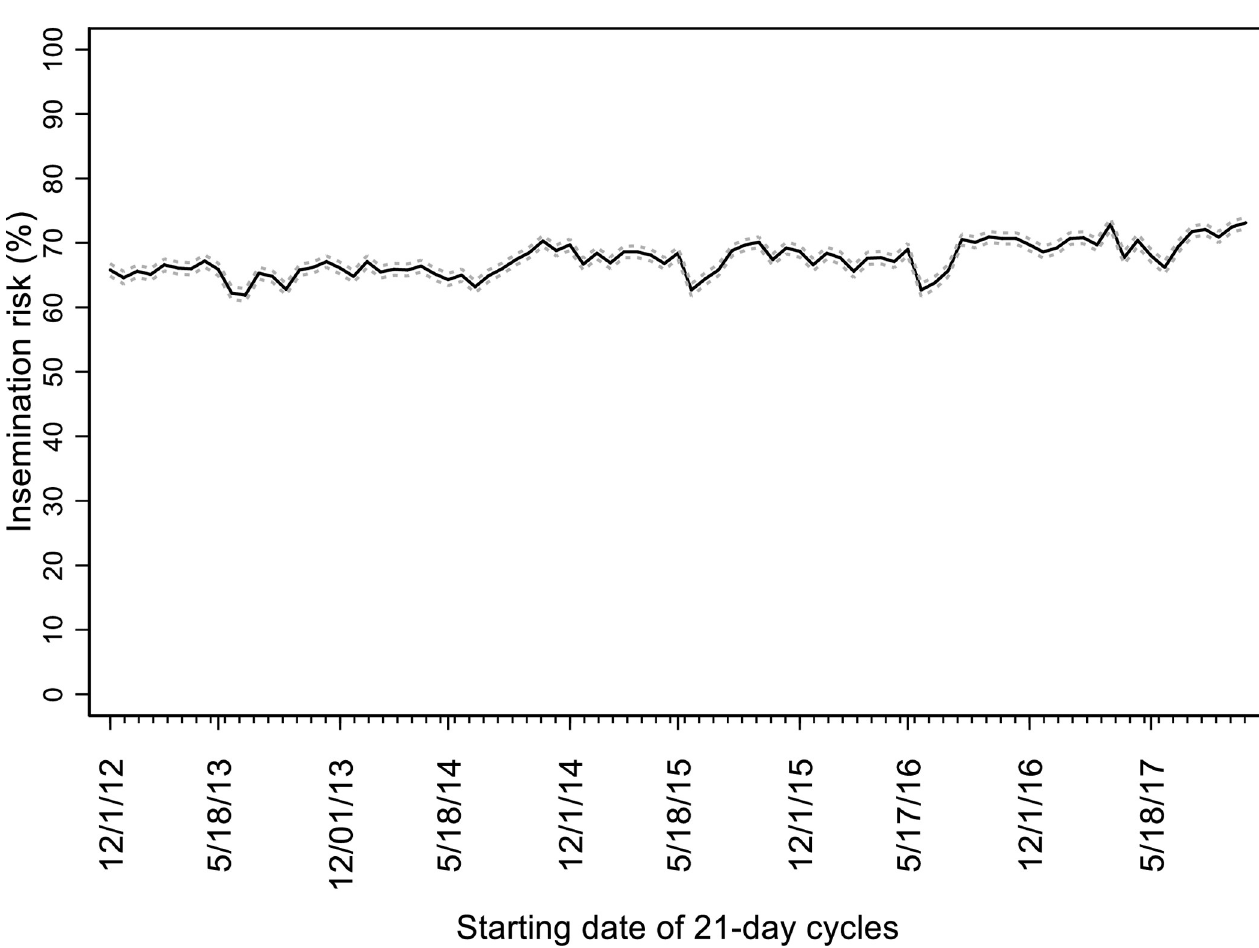
Fig 1. Insemination risk of 9 large dairy herds located in Kansas. Black solid line represents mean insemination risk, and gray dotted lines represent 95% confidence interval for 21-day cycles (n = 85) starting December 1, 2012 through November 2, 2017.